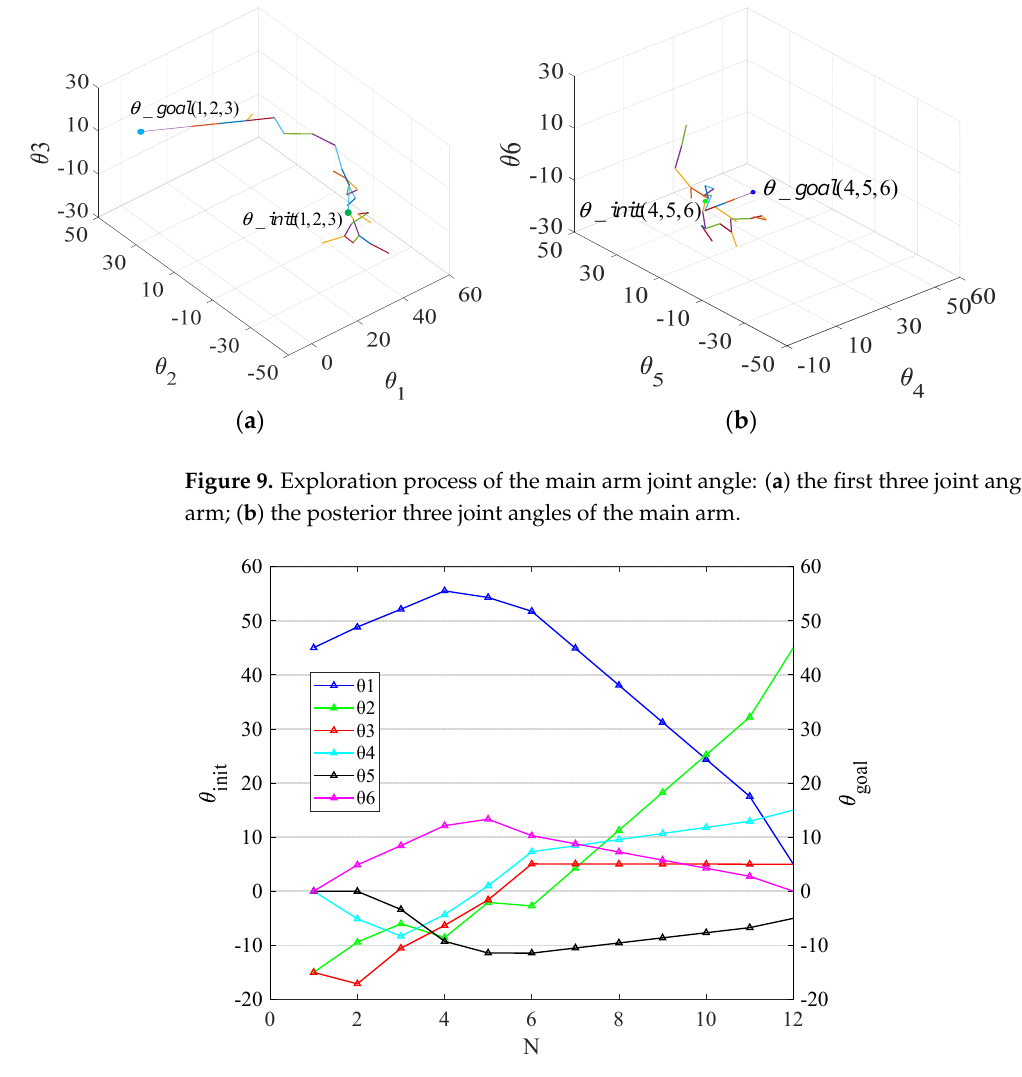
Figure 10. The final result of the path planning for the main arm.